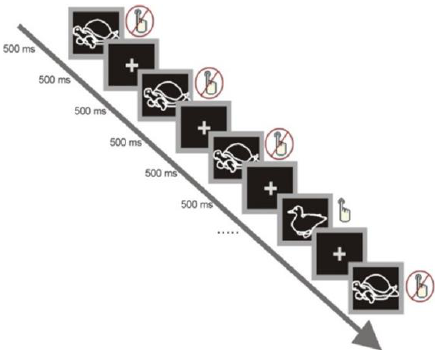
Figure 1. Stimulus presentation and time intervals of each trial in the Visual Sustained Selective-set Attention Task (VSSAT). Adapted from D’Angiulli and Devenyi (2019) [41].